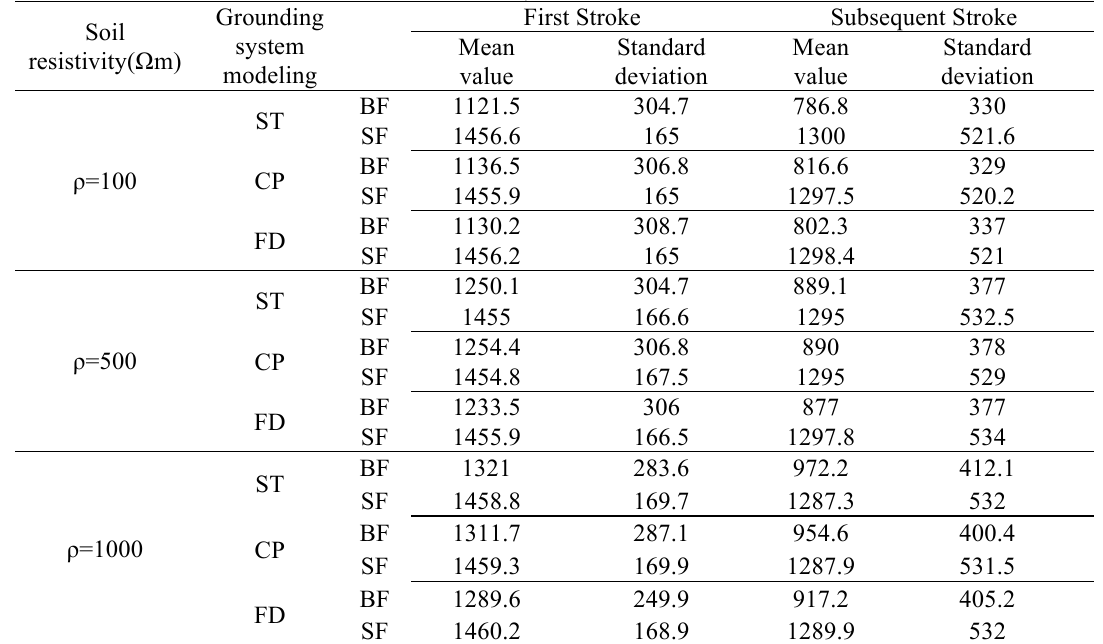
Table 7: Lightning overvoltage distribution (kV) for Different Modelling of Rod-shape (15m) Grounding system.